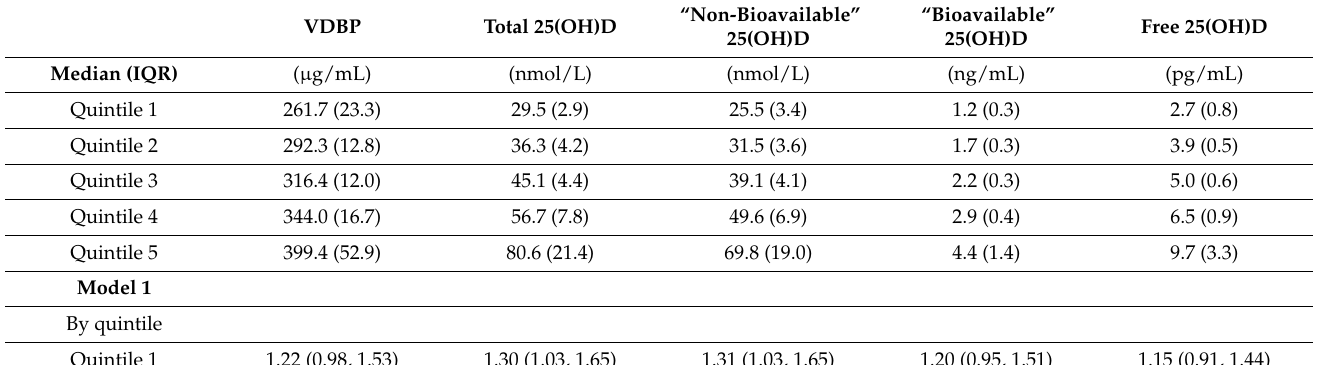
Table 2. Hazard ratios (95% CI) of developing diabetes by quintiles and per standard-deviation de- crease in VDBP, as well as total, “non-bioavailable”, “bioavailable”, and free 25(OH)D concentrations, adjusted for covariates.